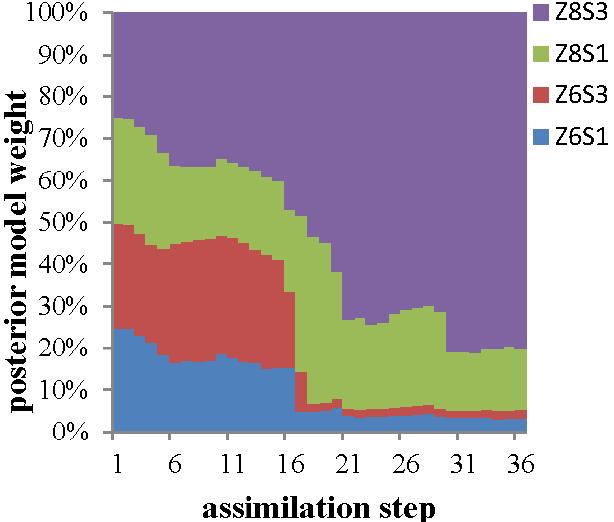
Figure 7. Posterior model weights changing with time for individual postulated